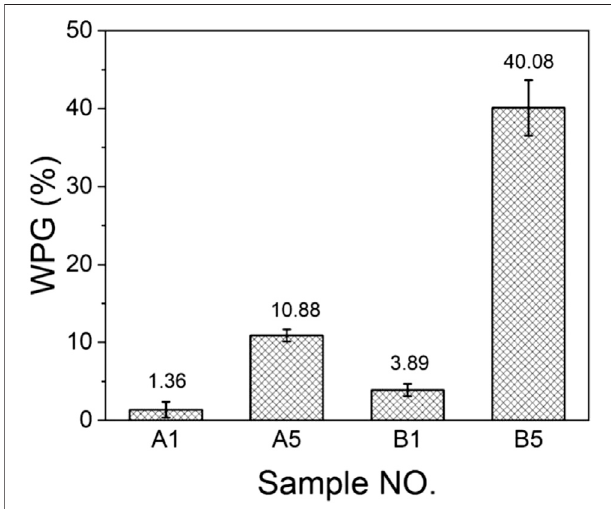
FIGURE 2 | WPG of bamboo specimens at different times of LbL self- assembly with PA-PEI.